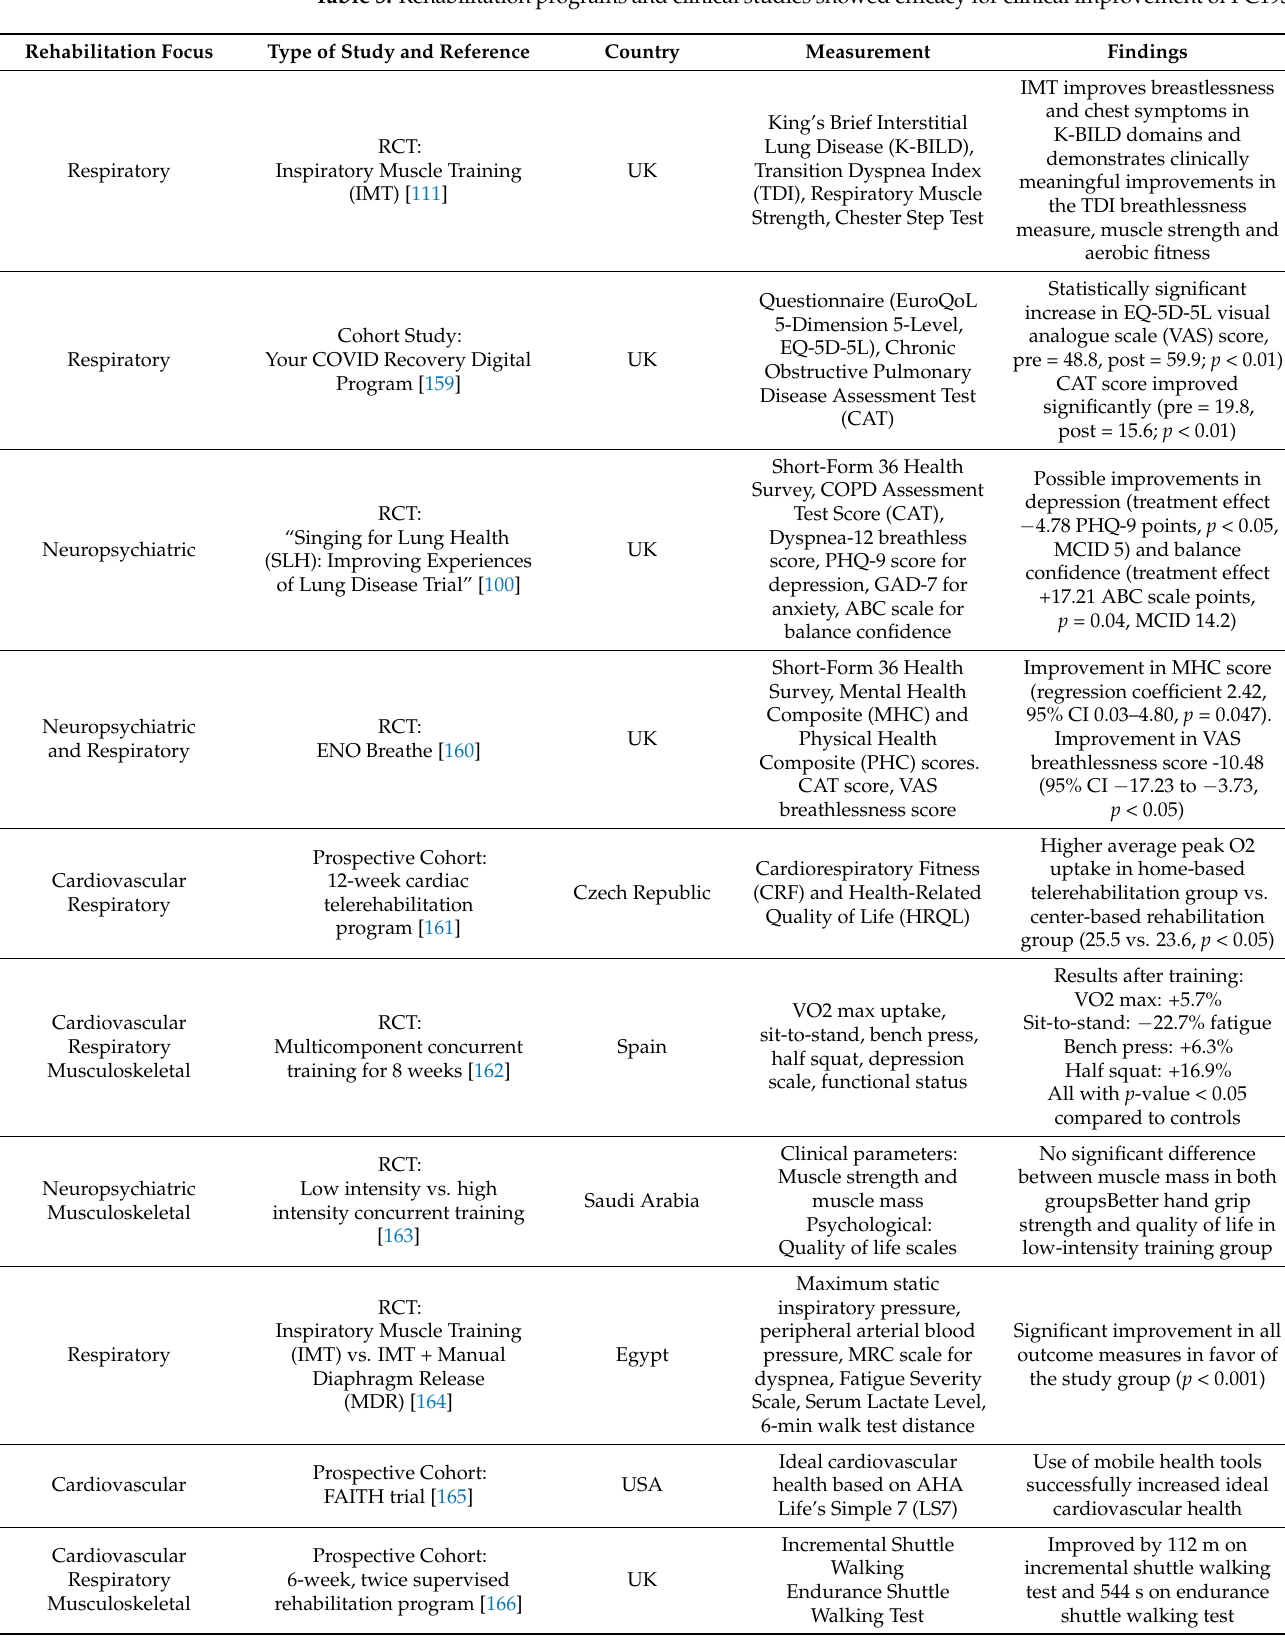
Table 5. Rehabilitation programs and clinical studies showed efficacy for clinical improvement of